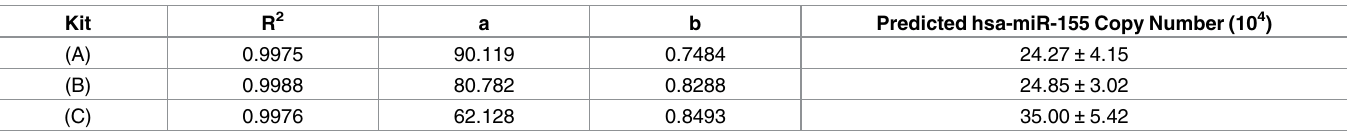
Table 7. Sample specific linear power model for individual